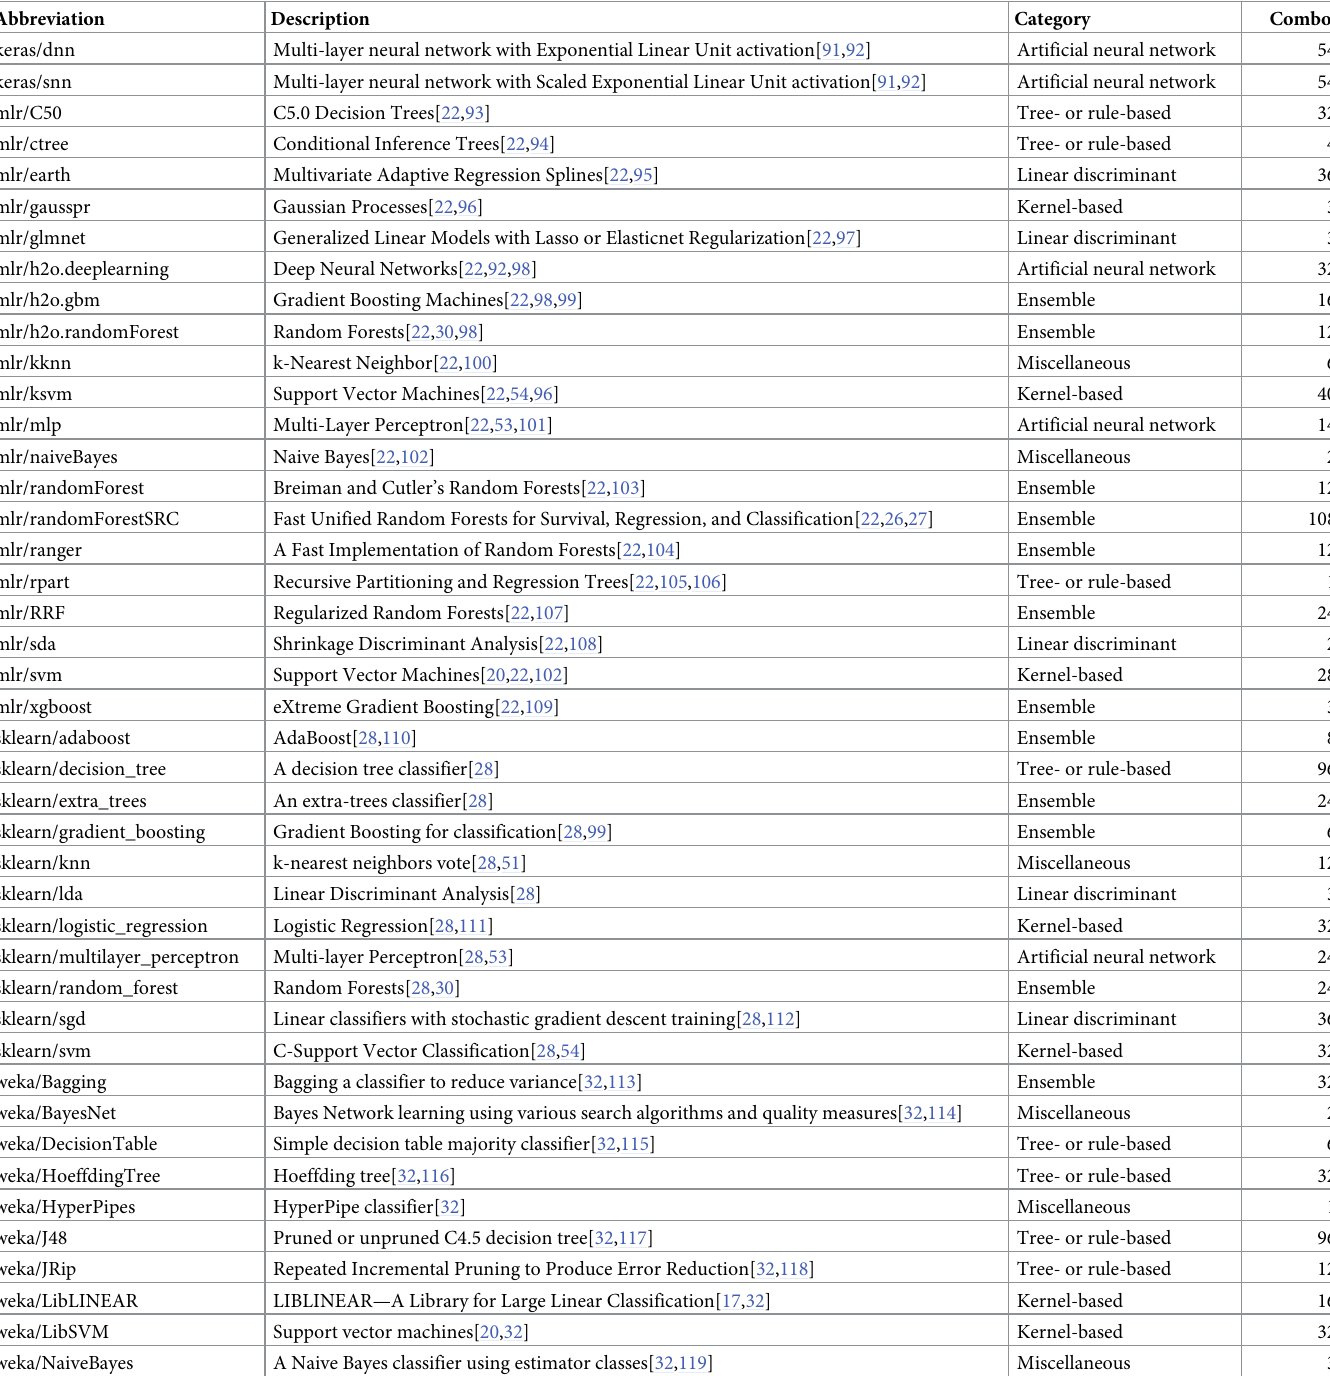
Table 2. Summary of classification algorithms. We compared the predictive ability of 52 classification algorithms that were available in ShinyLearner and had been implemented across 4 open-source machine-learning libraries. The abbreviation for each algorithm contains a prefix indicating which machine-learning library imple- mented the algorithm (mlr = Machine learning in R, sklearn = scikit-learn, weka = WEKA: The workbench for machine learning; keras = Keras). For each algorithm, we provide a brief description of the algorithmic approach; we extracted these descriptions from the libraries that implemented the algorithms. In addition, we assigned high- level categories that characterize the algorithmic methodology used by each algorithm. In some cases, the individual machine-learning libraries aggregated algorithm implementations from third-party packages. In these cases, we cite the machine-learning library and the third-party package. When available, we also cite papers that describe the algorithmic methodologies used. Finally, for each algorithm, we indicate the number of unique hyperparameter combinations evaluated in Analysis